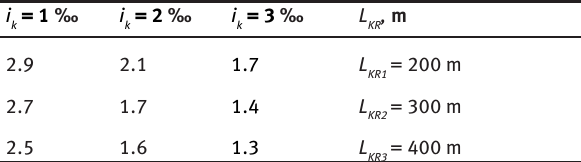
Table 3: A comparison of rainwater outflow from traditional and innovative sewer system taking into account different variants of their working. Ratio of maximum rainwater outflow traditional to innovative system, at various slope of canals bottom i spacing LK